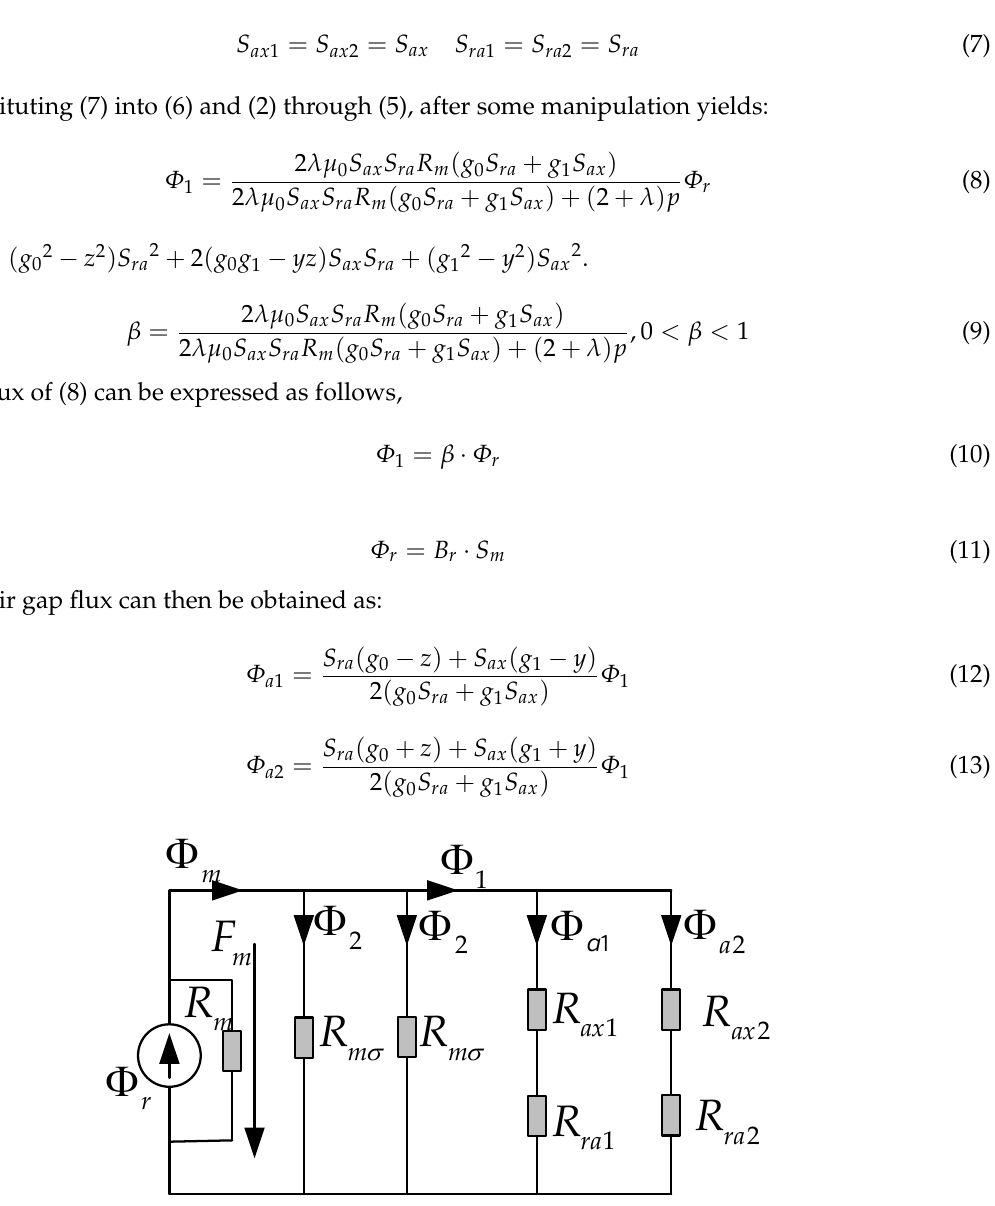
Figure 4. Equivalent magnetic circuit of the PM ring.